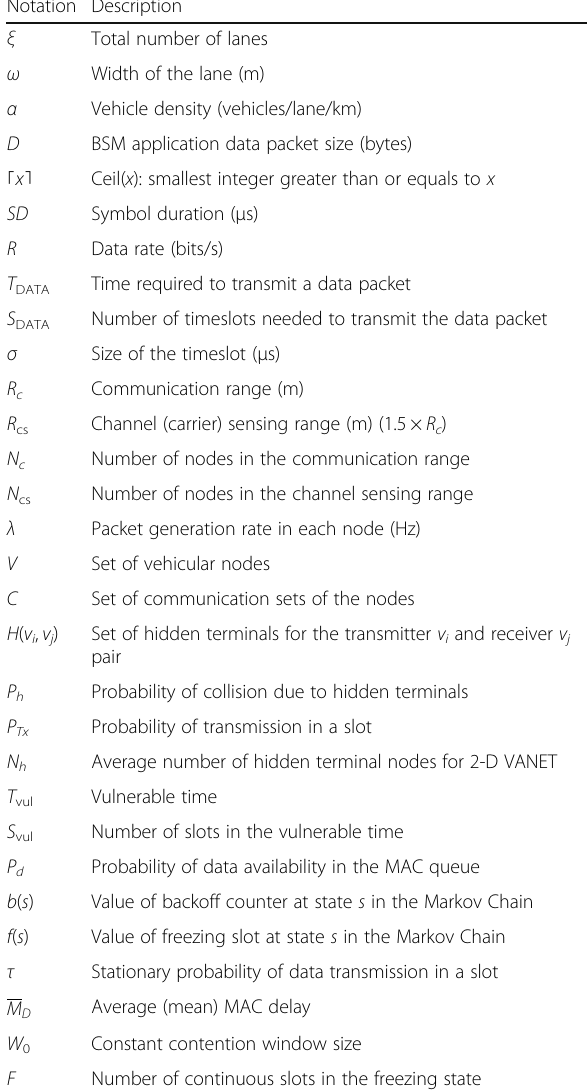
Table 1 Most frequently used modeling notations Notation